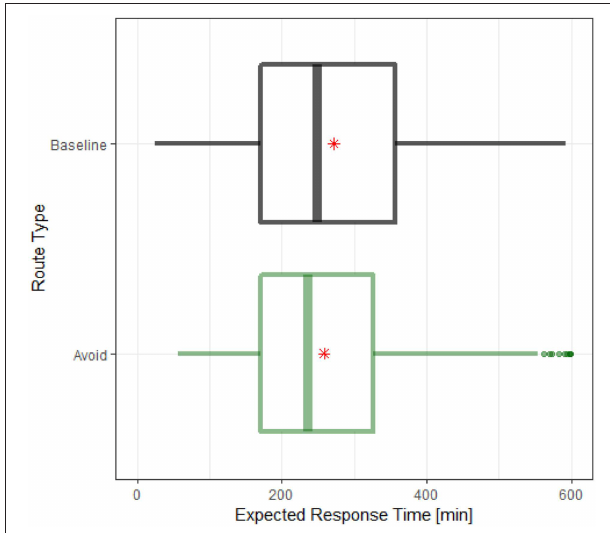
FIGURE 8 | Boxplots of expected (mean) response times across 10,000 states-of-the-world for 518 routes. Red star shows mean values.